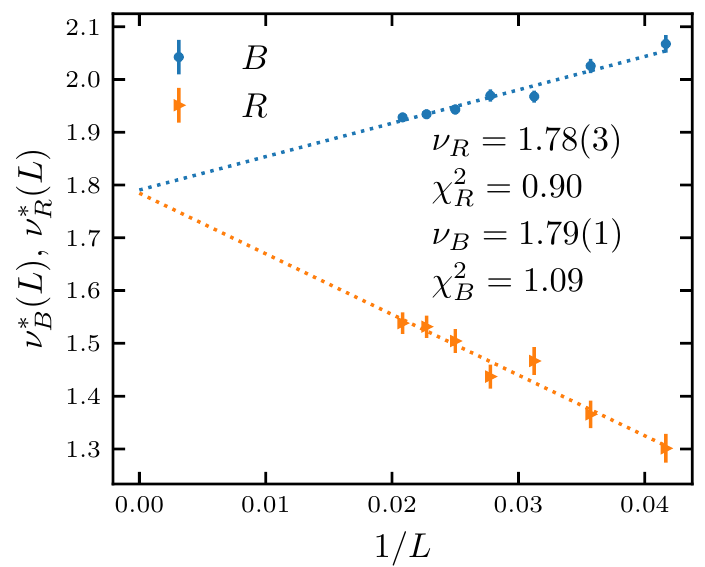
Figure 4: Extrapolation of the exponent ν ∗ ( L ) for both the Binder cumulant B (cir- cles) and the log string-order parameter ratio R (triangles) as a function of 1 / L for different system sizes. The legend indicates the extrapolated values for ν along with the normalized χ 2 values for each